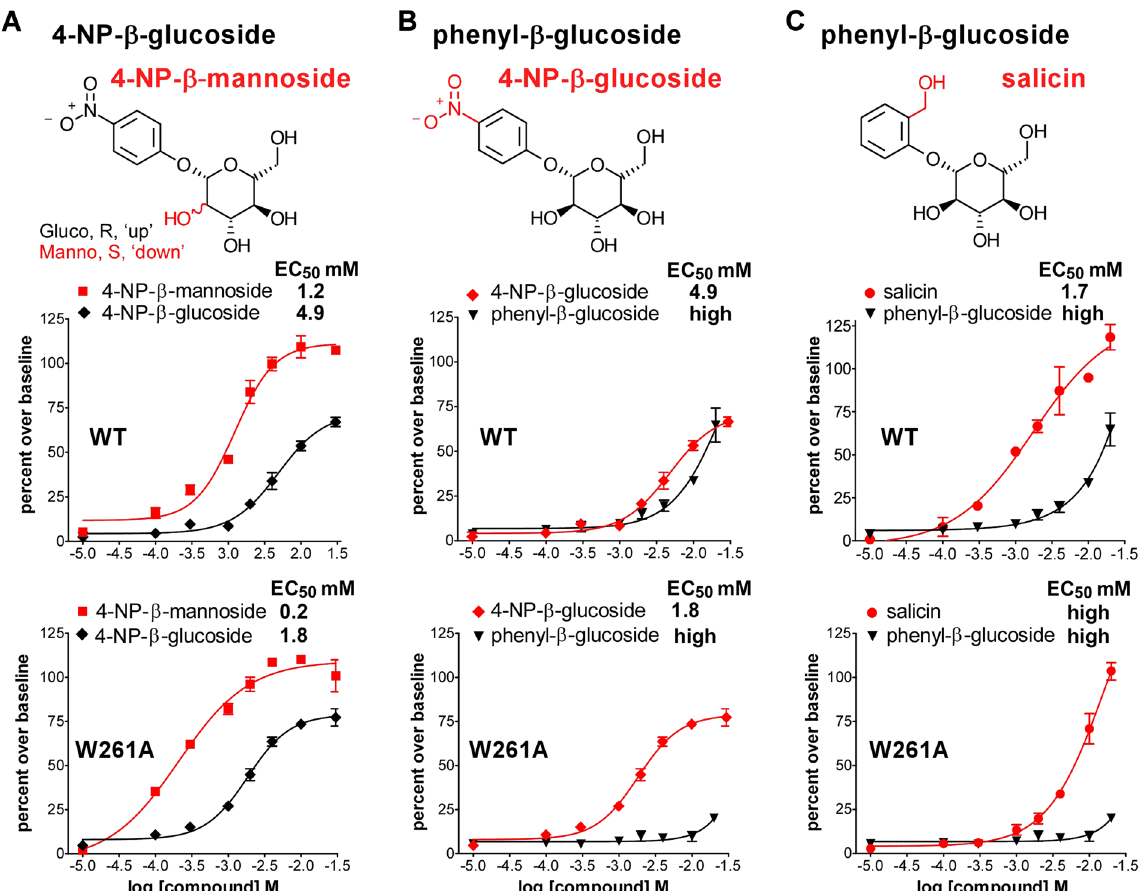
Figure 6. Specific ligand substitutions decrease the EC 50 values for TAS2R16 activation. Comparative dose- response studies were performed with wild-type TAS2R16 and the W261A variant for ligand pairs ( a ) 4-NP- β -mannoside and 4-NP- β -glucoside, differing in the orientation of the 2 ′ -OH group, ( b ) 4-NP- β -glucoside and phenyl- β -glucoside, and ( c ) salicin and phenyl- β -glucoside. Error bars represent the standard deviation, n = 4–8 replicate